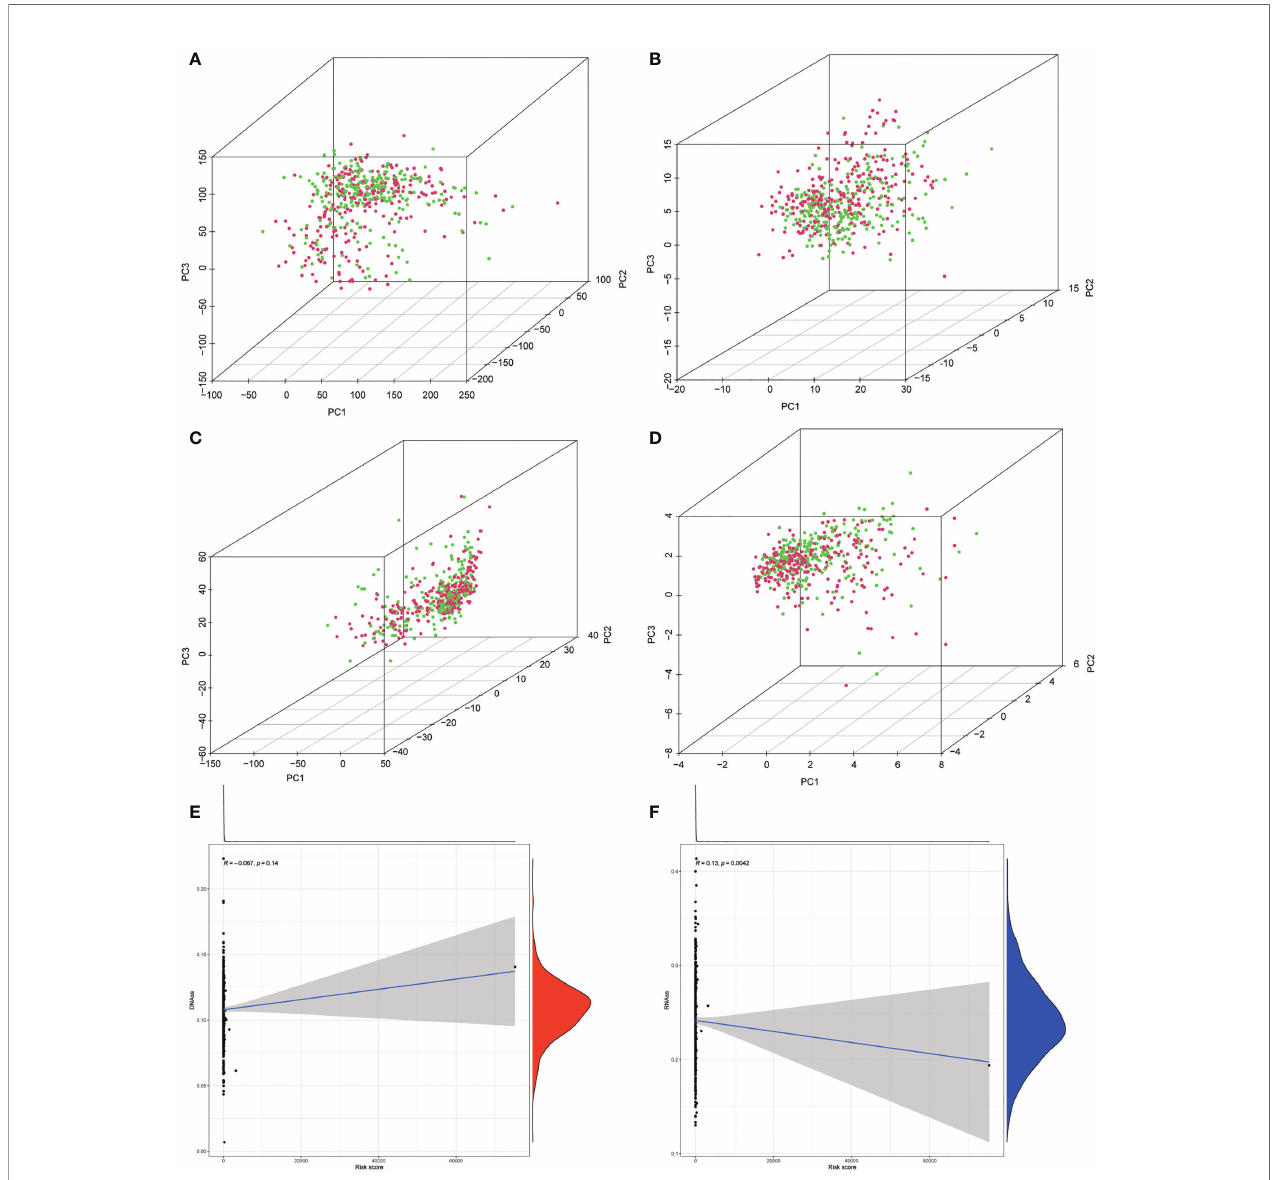
pro fi les. (E, F) The correlation among risk strati fi cation and tumor stem cell score (based on RNA expression and DNA methylation). (E) The correlation between the risk strati fi cation and DNA stemness index. (F) The correlation between the risk strati fi cation and RNA stemness